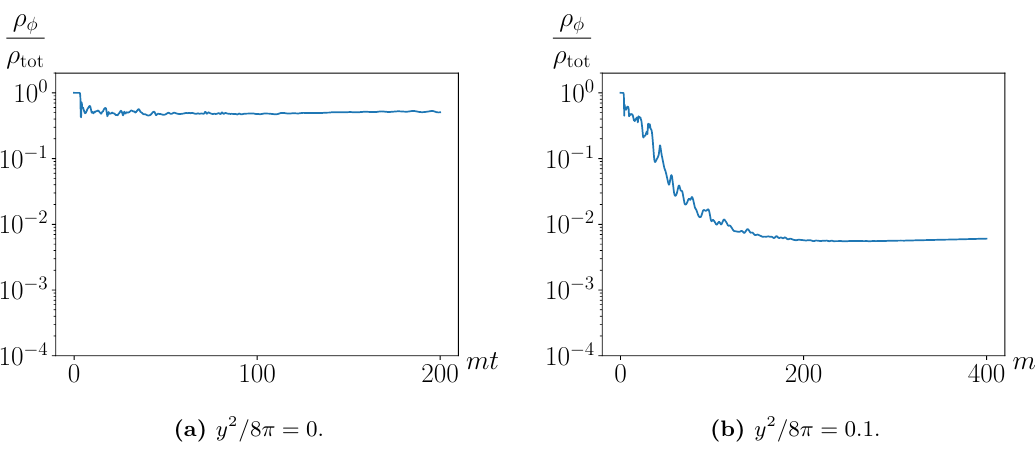
Figure 3. Time evolution of ρ φ /ρ tot for b = 0 . 9 , m = 10 − 6 M pl , Φ 0 = f = M pl , q 0 = 200 and y 2 / 8 π = 0 or 0.1. The initial rapid decrease is due to tachyonic production of χ . When y 6 = 0 , the χ → ¯ ψψ decay alleviates χ ’s backreaction on φ , and ρ continues to decrease. After the φ /ρ tot second stage of energy transfer ends, ρ slowly increases since φ is matter-like and redshifts φ /ρ tot slower than the rest of the system, which is